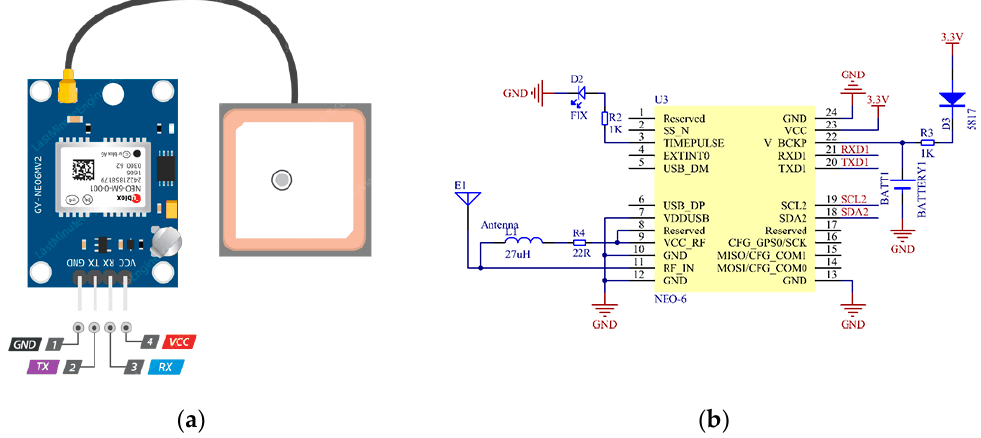
Figure 3. Module of GPS NEO-6M V2: ( a ) Connection scheme [52]; ( b ) hardware schematic [53].